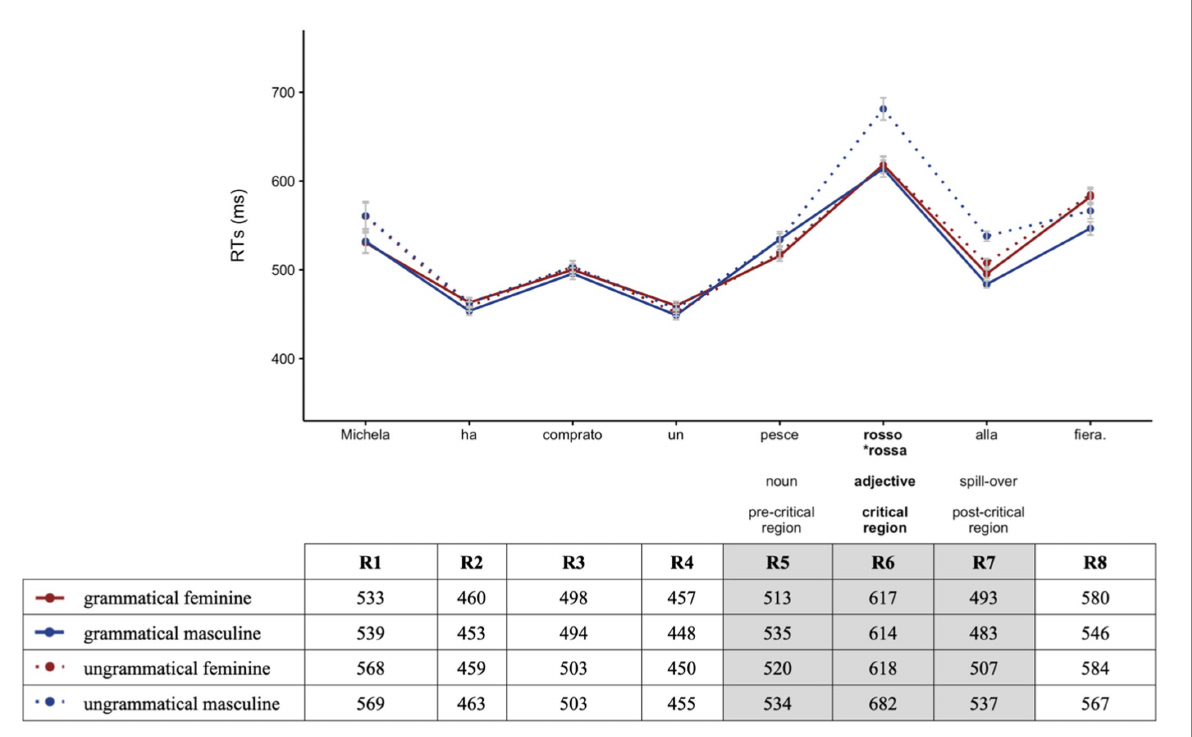
FIGURE 2 Heritage speakers (HSs’) mean reading times (RTs) by region for grammatical (solid lines) vs. ungrammatical (dotted lines) sentences for feminine (red) and masculine (blue).